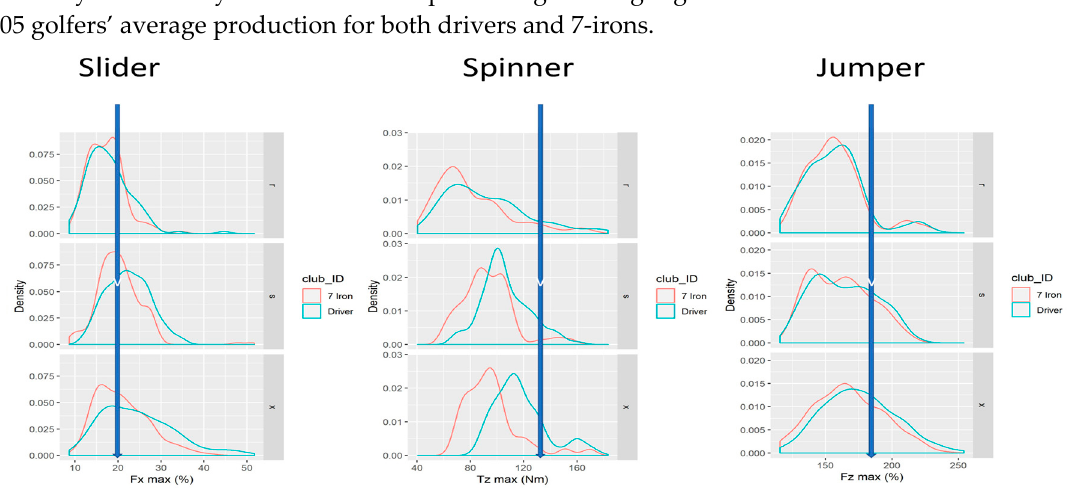
Figure 2. Density plot all the golfers’ force productions differentiated by club (color) and faceted by the shaft flex. The PGA tour average threshold (blue line) is